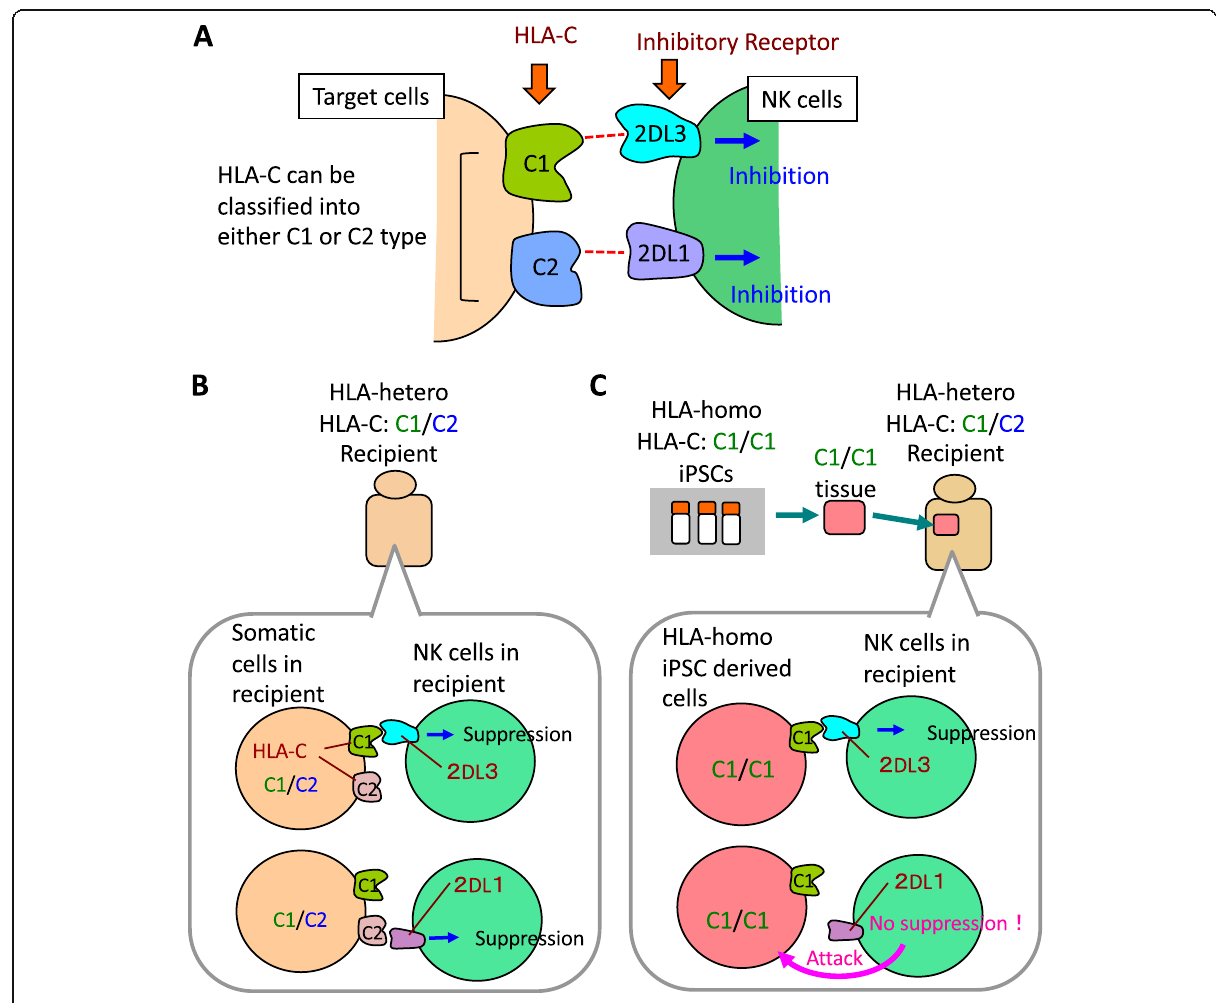
Fig. 2 The mechanism of NK cell-based immune responses. a Inhibitory receptors and ligands of NK cells. HLA-C molecules function as the major ligands of inhibitory receptors expressed on NK cells. HLA-C molecules can be classified into two types, C1 or C2. The receptor for C1 or C2 is KIR2DL3 (2DL3) or KIR2DL1 (2DL1), respectively. b NK cells in recipients carrying HLA-C1/C2 are inhibited by the ligand of either HLA-C1 or HLA- C2 expressed on somatic cells. c It is predicted that HLA-hetero C1/C2 recipient NK cells may sense the missing of the C2 molecule on the graft based on the lack of inhibitory signaling when regenerated tissues derived from HLA-homo iPSCs carrying HLA-C1/C1 are